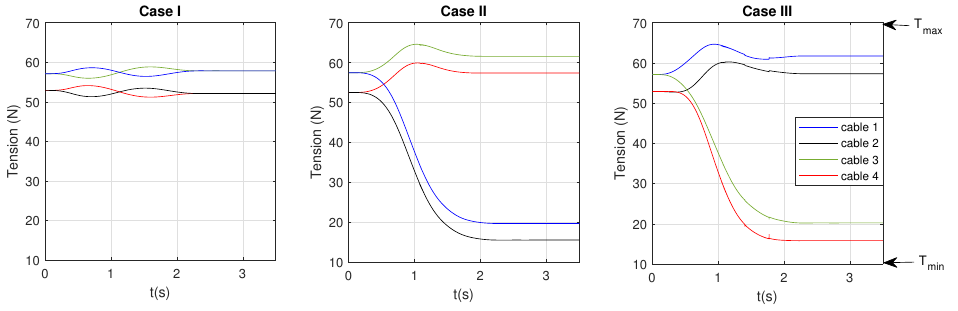
Figure 12. Cable tensions: Cases I, II, and